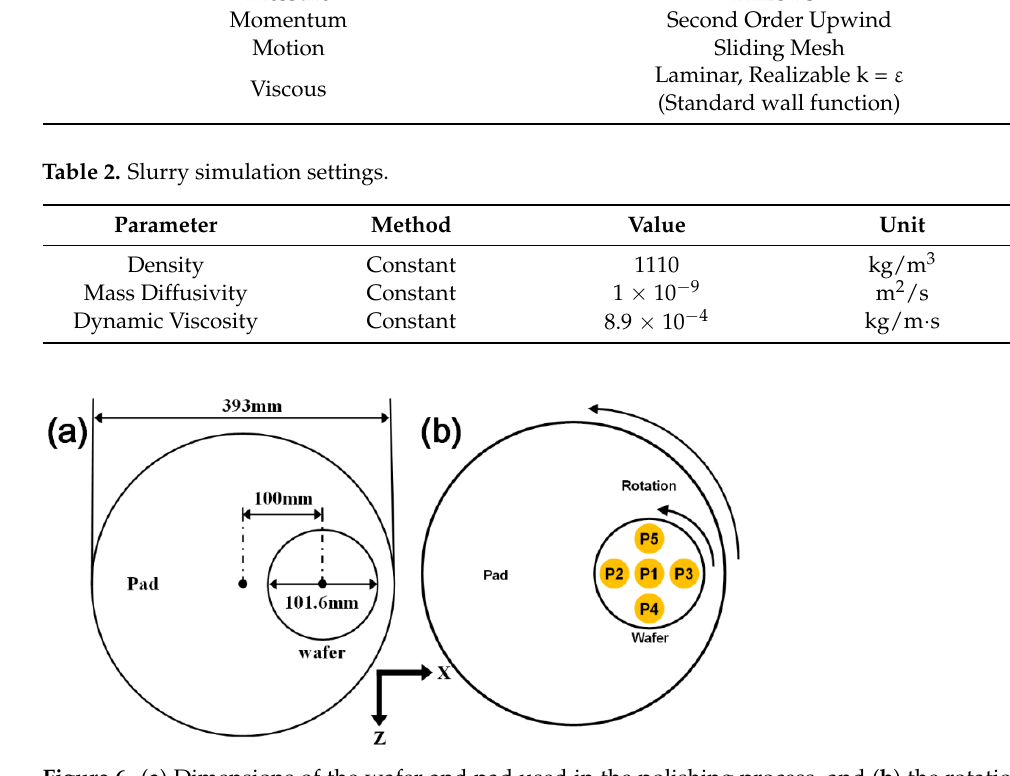
Figure 6. ( a ) Dimensions of the wafer and pad used in the polishing process, and ( b ) the rotation direction and five monitoring points in the pad–wafer interface. Table 3. The coordinates of five monitoring